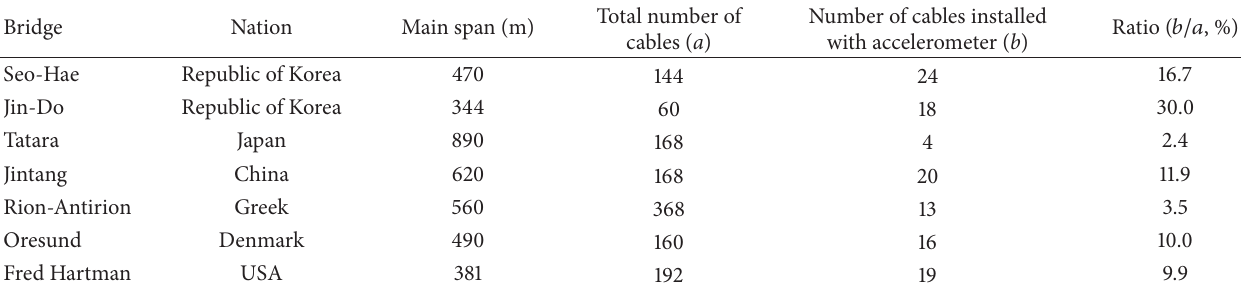
Table 2: Accelerometer-based cable monitoring systems in different countries